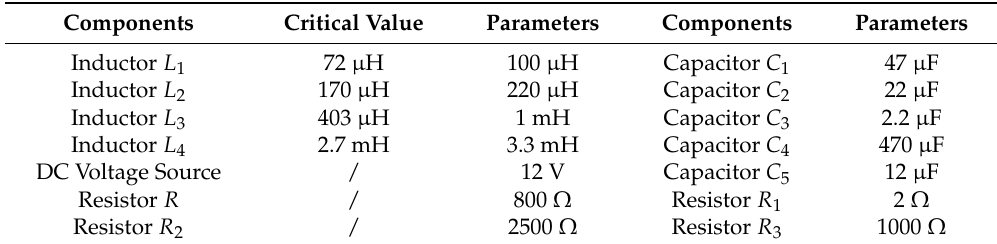
Table 3. Circuit parameters and number of